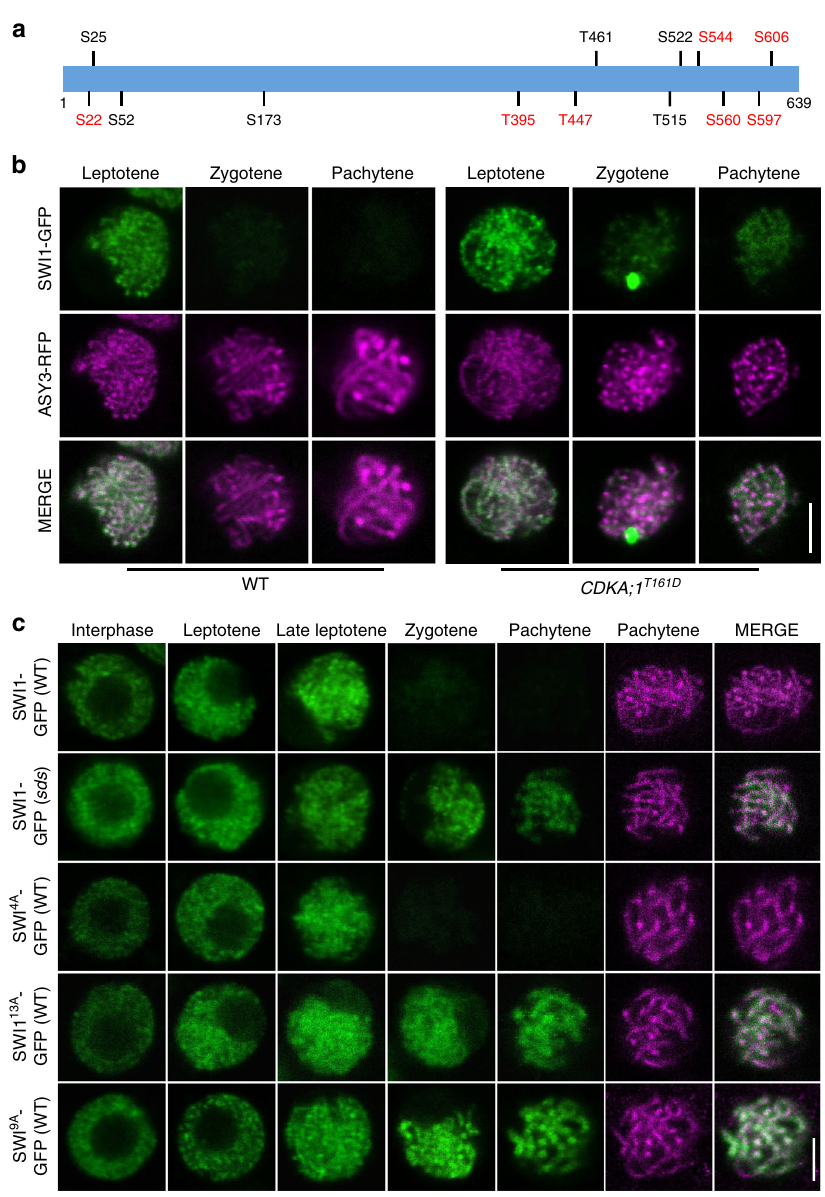
Fig. 6 Phospho-control of SWI1 localization. a Schematic representation of SWI1 with the position of the 13 [S/T]P motifs. Phosphorylated sites identi fi ed by mass spectrometry are labeled in red. S serine, T threonine. b Confocal laser scanning micrographs of SWI1-GFP in comparison with ASY3-RFP as a meiosis staging marker in the wildtype (WT) and CDKA;1 T161D male meiocytes. c The expression of SWI1-GFP and the de-phospho mutants SWI1 4A -GFP, SWI1 9A -GFP and SWI1 13A -GFP were analyzed in interphase and prophase I of male meiocytes of sds mutants and wild-type plants (WT), respectively. ASY3-RFP localization is only shown for pachytene. Bar: 5 μ